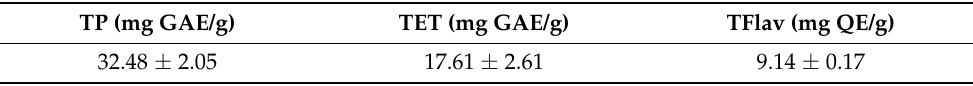
Table 5. The content of polyphenols compounds in the D. morbifera leaves.